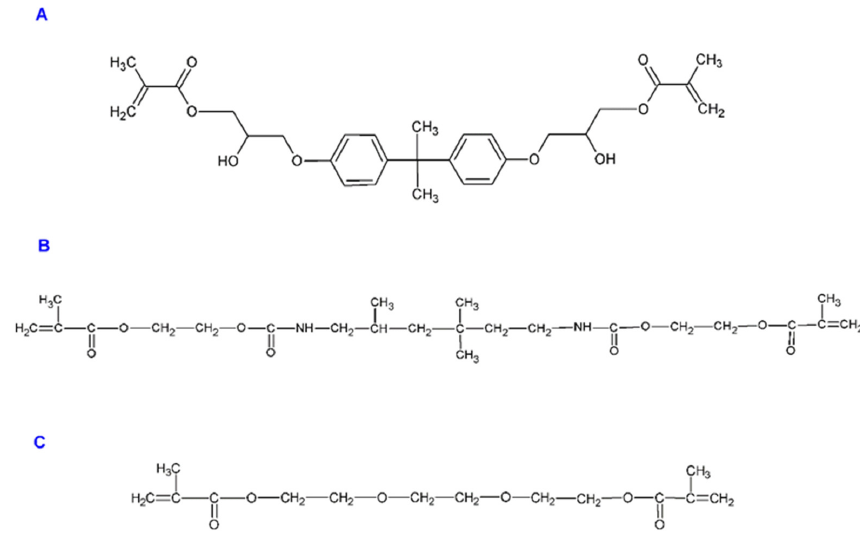
Figure 1. Structures of Bis-GMA ( A ), UDMA ( B ) and TEGDMA ( C ) monomers. Samples of the materials were prepared in the form of a pellet, 5 mm in diameter and 2 mm thick and were made in the shape of cylinders using a polyethylene matrix. The material was polymerized according to the manufacturer’s recommendations. After cur- ing, the samples were polished and conditioned, corresponding to the regular protocol in a clinical setting. Their contact area was calculated. Subsequently they were immersed in the studied solutions and left without stirring in closed containers at 37 °C for a suitable period to determine the fluoride release from the materials. Five samples of each material were prepared for each environment (total n = 30). Each sample was examined three times, and an average value was calculated based on the three results.